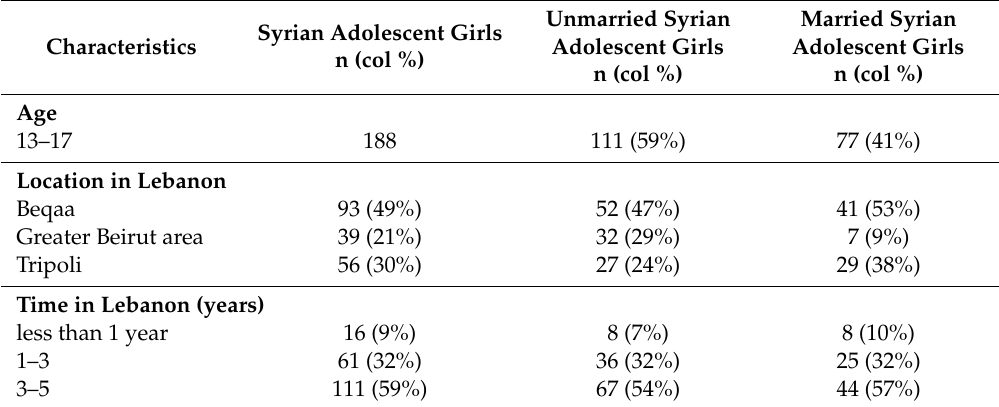
Table 1. Characteristics of the Study Sample of Syrian Adolescent